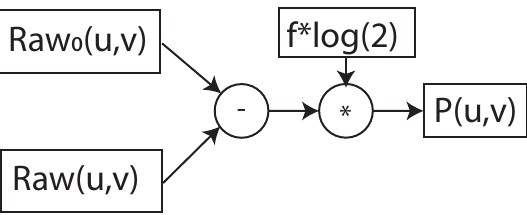
Figure 4. Data flow graph representation for the optimized I0-correction.